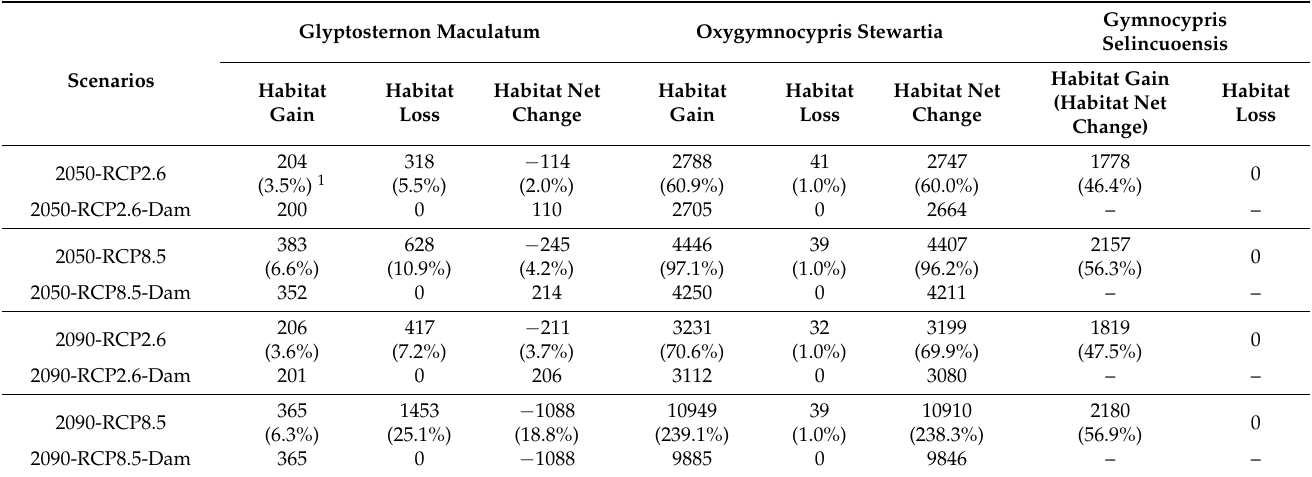
Table 2. Habitat changes of three species under four scenarios.